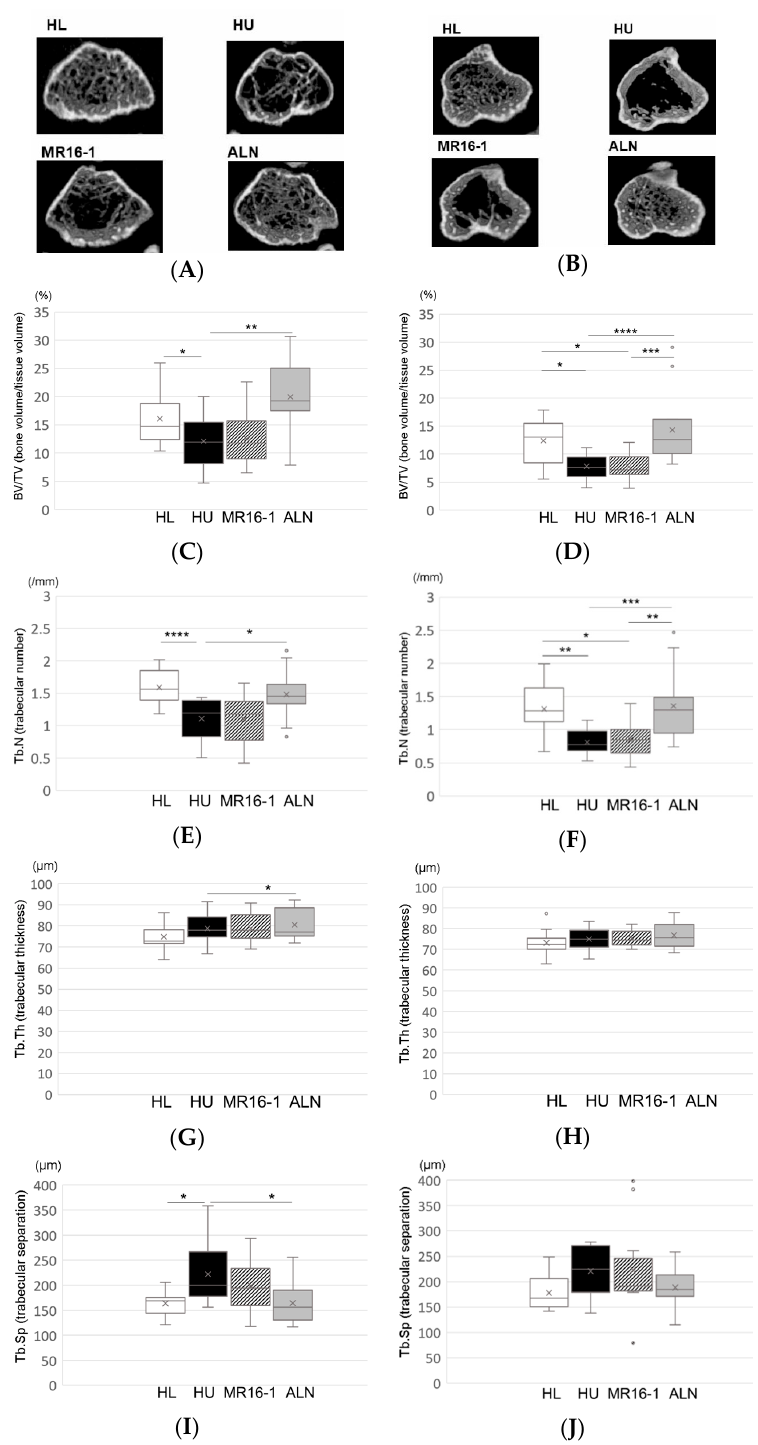
Figure 3. Micro-CT analyses of the distal femoral metaphysis and the proximal tibial metaphysis: Three-dimensional images of the distal femoral metaphysis ( A ) and the proximal tibial metaphysis ( B ), ( C ), ( D ) BV/TV (bone volume/tissue volume) (%), ( E ), ( F ) Tb.N (trabecular number) (/mm), ( G ), ( H ) Tb.Th (trabecular thickness) ( μ m), and ( I ), ( J ) Tb.Sp (trabecular separation) ( μ m). Top, bottom, and middle lines of the graph correspond to the 75th percentile, 25th percentile, and median, respectively. Cross represents mean. Each circle represents an outlier ( n = 8 in each group). * p < 0.05, ** p < 0.01, *** p < 0.005, and **** p < 0.001.